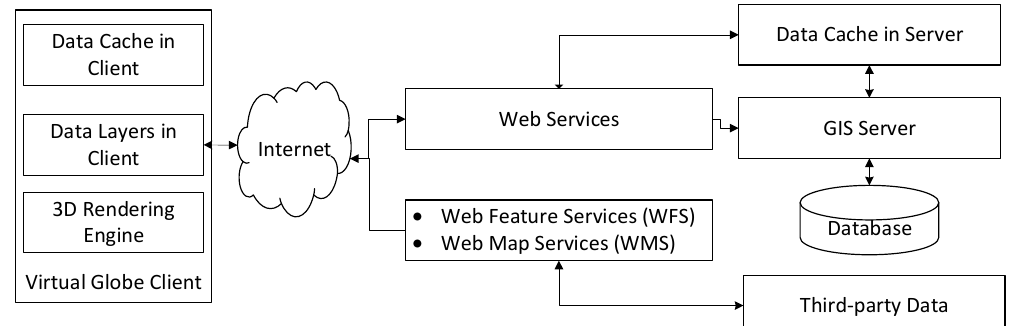
Figure 2. The general framework of the 3D virtual globe platform.